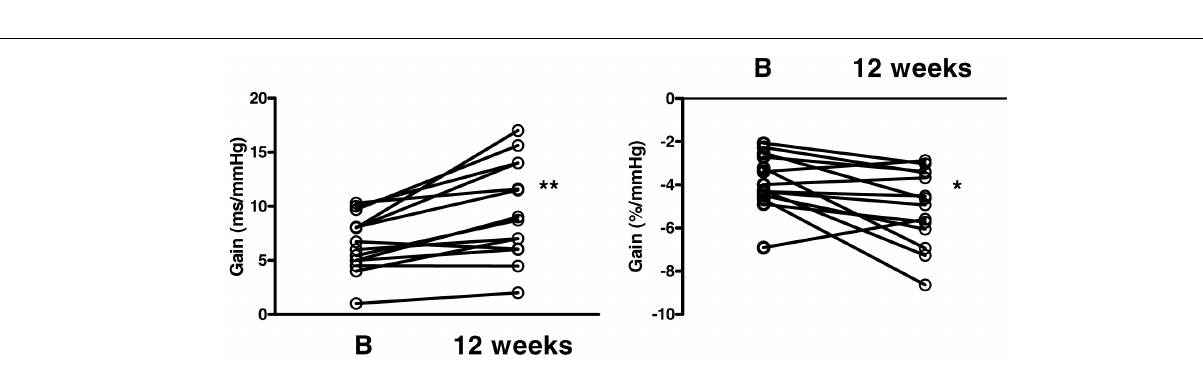
FIGURE 4 | Cardiac (left panel) and sympathetic (right panel) baroreflex function gain measured at baseline (B) and 12weeks following the diet. * P < 0.05, ** P <